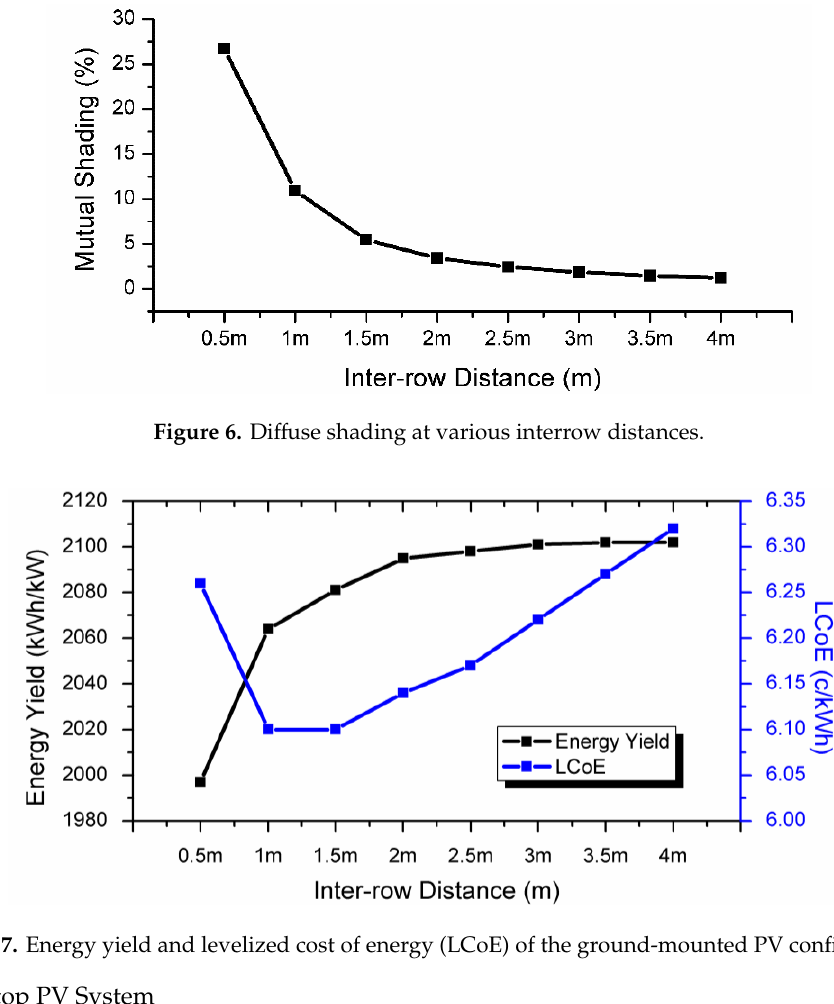
Figure 5. Parallel tilted PV modules facing sun and their shading caused by tilt angle.